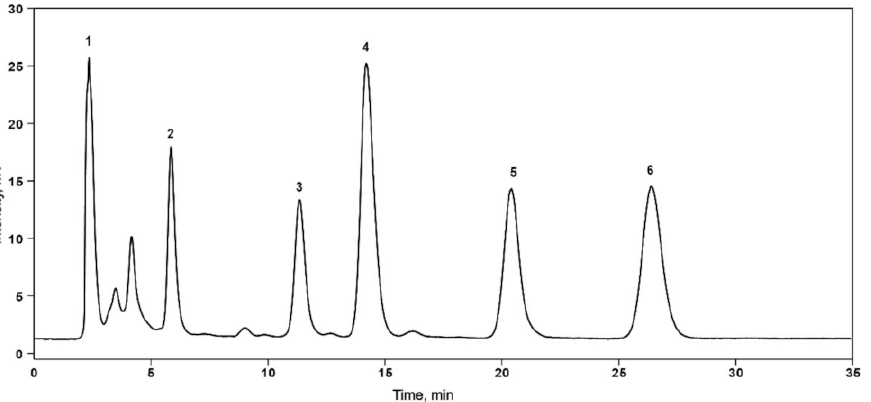
Figure 2. HPLC chromatogram of aqueous 75% methanol extract of cones of ‘Kauno gražieji’ hop variety. (1—compounds that are not retained by reversed phase stationary phase; 2—xanthohumol; 3—cohumulone; 4—humulone; 5—colupulone; 6—lupulone; λ = 348 nm).